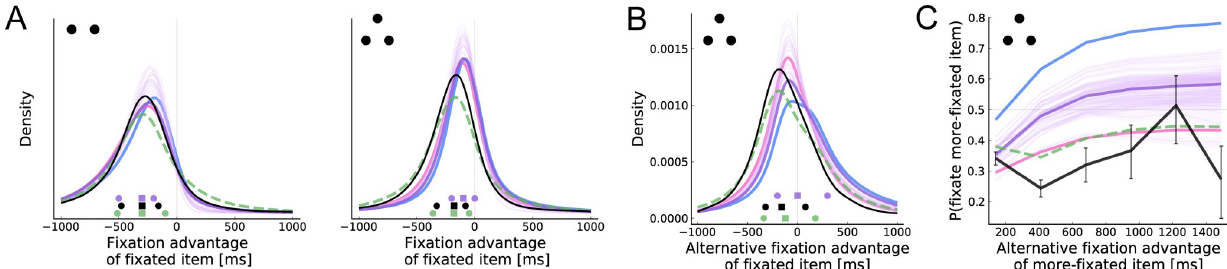
Fig 5. Uncertainty-directed attention. (A) Distribution of fixation advantage of the fixated item, computed at the beginning of each new fixation. Fixation advantage is defined as the cumulative fixation time to the item minus the mean cumulative fixation time to the other item(s). First fixations are excluded in this plot. (B) Similar to A, except that we compare the fixation advantage between the fixated item and the other item that could have been fixated but was not. First and second fixations are excluded in this plot. (C) The probability that the item with greater alternative fixation advantage is fixated, as a function of that advantage. See Fig 3 for more